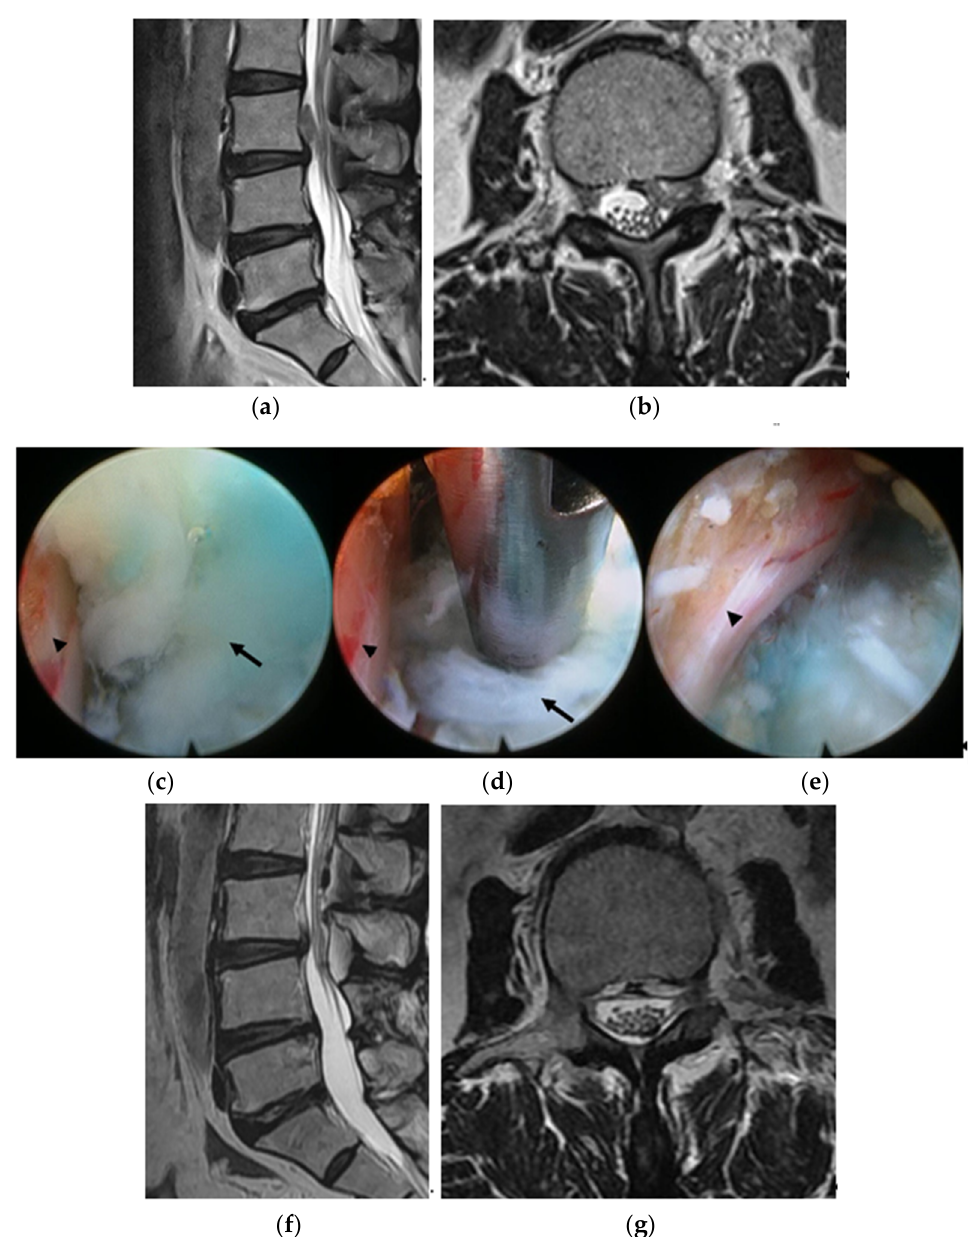
Figure 3. A 45-year-old man presenting with radiating pain in the left buttock and anterior thigh. Magnetic resonance imaging (MRI) revealed disc herniation with upward migration zone type C at L3–L4 ( a,b ). Ruptured disc particles were removed using the full endoscopic transforaminal approach (arrow: ruptured disc particles, arrow head: left side L3 nerve root, ( c,d ). After the full endoscopic transforaminal approach, the left side L3 nerve root was decompressed ( e ). A postoperative MRI showing that migrated ruptured disc particles were completely removed ( f,g ).